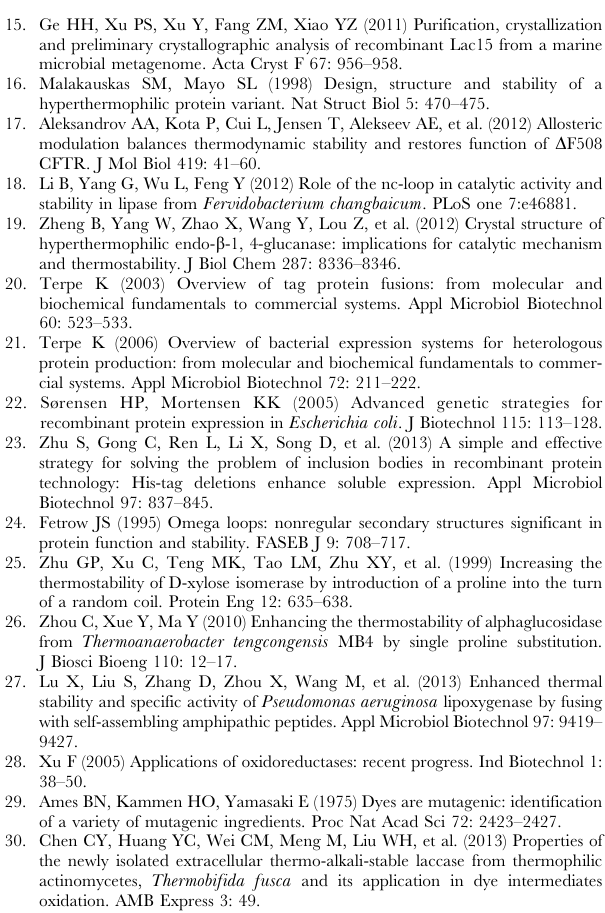
Figure S1 Construction of different genes in the pET22b( + ) plasmid and the proteins expressed by these constructs. Lac15-His 6 , single His-tag fusion at the C-terminus.